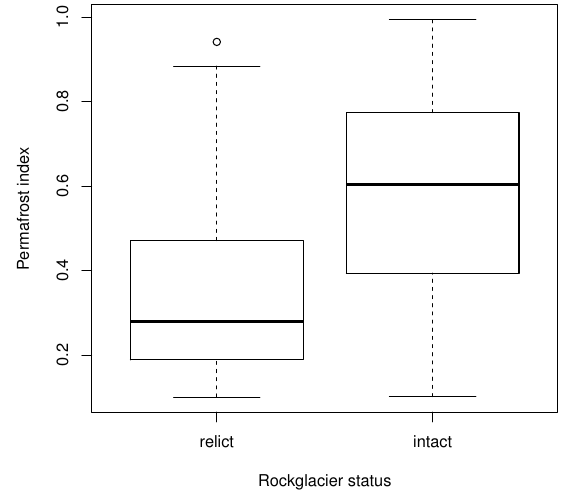
Fig. 7. Permafrost index values for intact and relict rock glaciers that were not used for model calibration. A random point within each rock glacier polygon was used for this figure.